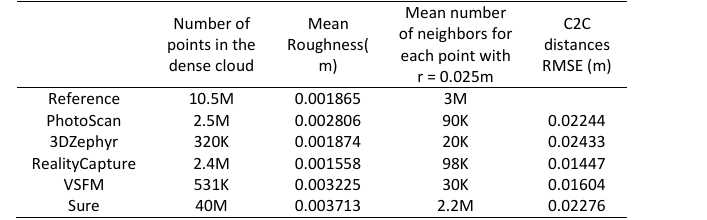
Figure 3: C2C Comparisons. Upper left: Photoscan, Upper right: Reality Capture, Middle Left: 3D Zephyr, Middle right: VSFM, Bottom: